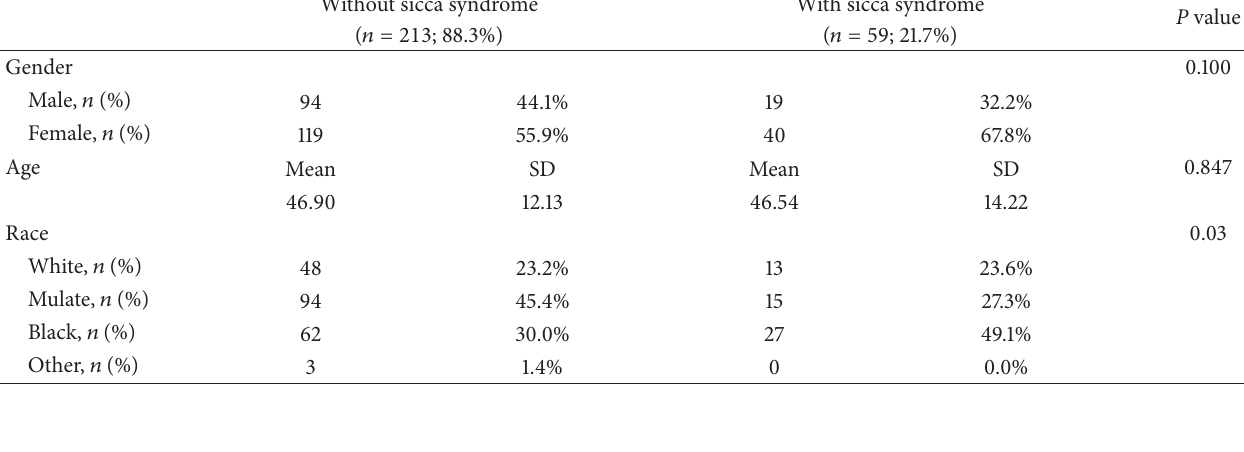
Table 1: Demographic characteristics of patients with and without sicca syndrome associated with HTLV-1 infection. Without sicca syndrome